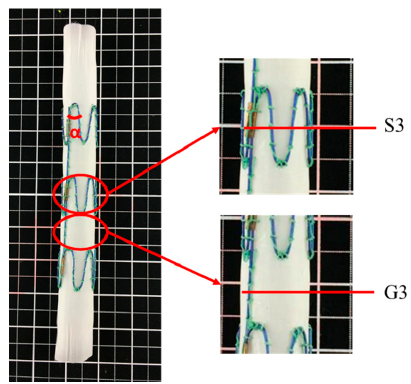
Figure 4. Test sites of stented zone S3 and unstented zone G3 along the longitudinal direction of the Z-stent-supported stent graft.